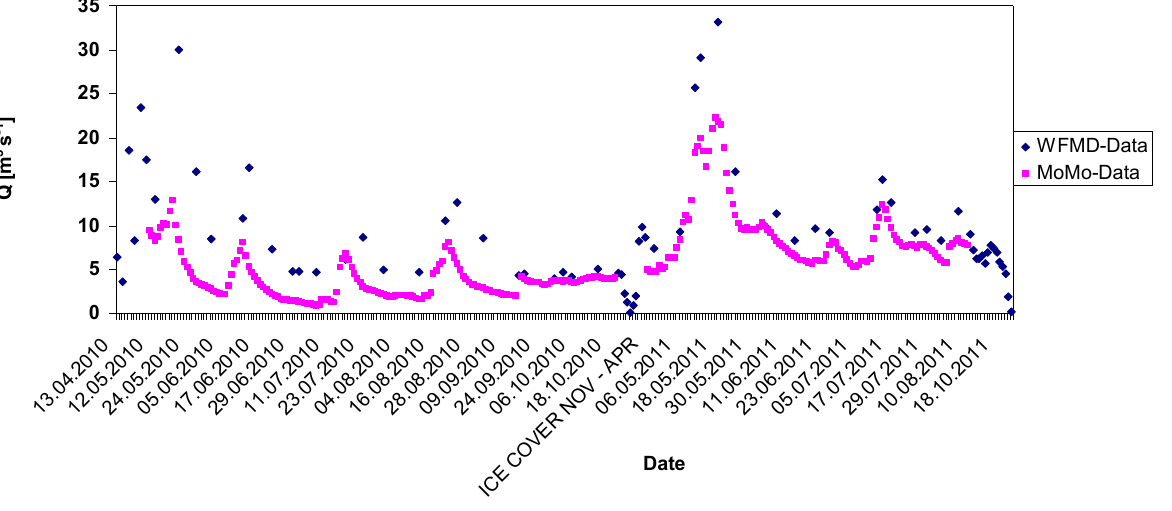
Figure 2. Comparison of discharge Q (observation period 13.04.2010 to 18.10.2011; no data during the period of ice cover between November and April) between Mongolian (Weather and Forecast Monitoring Department of Darkhan—WFMD) and MoMo data logger measurements at the outlet of Kharaa River Basin (KRB) (station Buren Tolgoi, 49°35 ′ 29 ″ N, 105°51 ′ 33 ″ E, 664 m